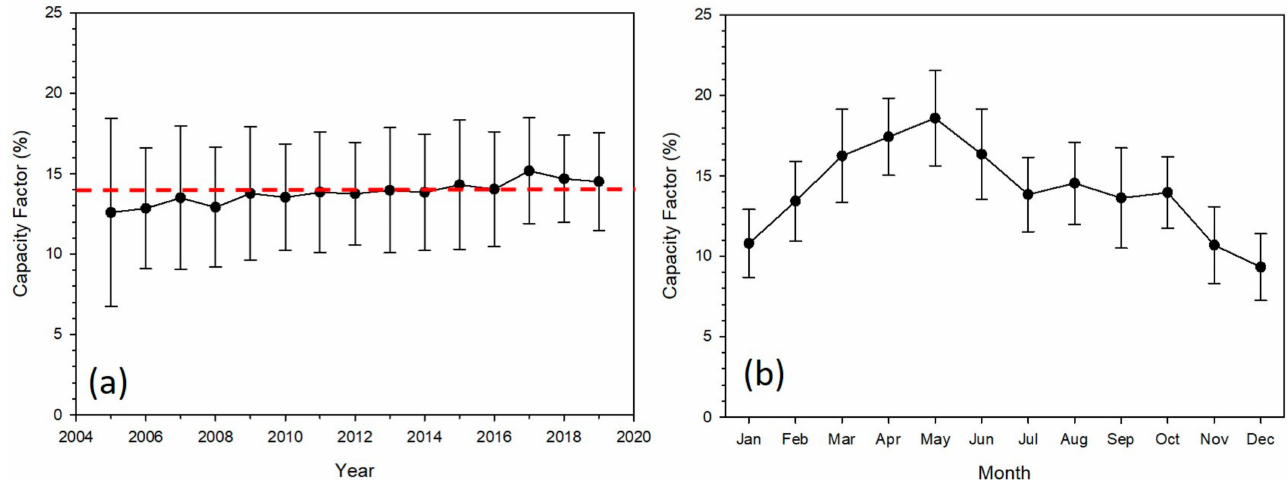
Figure 9. Capacity factor of photovoltaic systems in Korea with their standard deviation (bar) as a function of year ( a ) and month ( b ). Capacity factor in ( a , b ) is calculated by using EPSIS data. The red bar in ( a ) indicates the average value from 1996 to